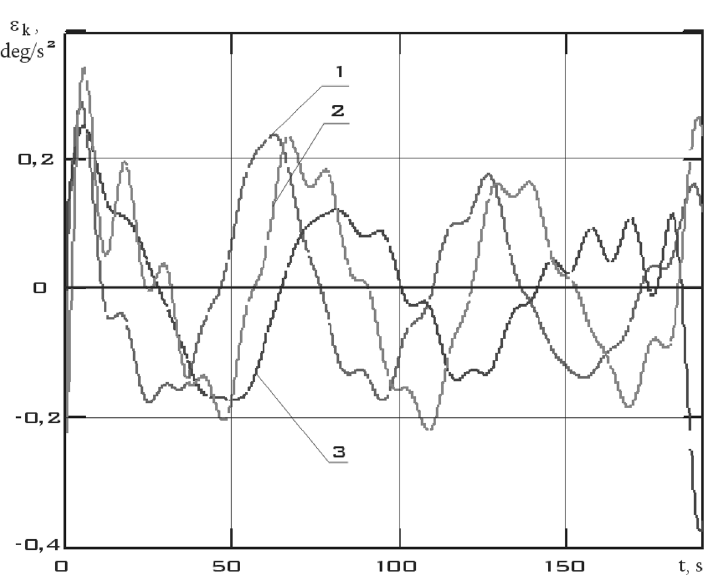
Figure 9. There are components of the angular acceleration vector in the CXYZ coordinate system 01/11/2014 from 01:45:14 to 01:48:20 (1 is ε x ; 2 is ε y ; 3 is ε z